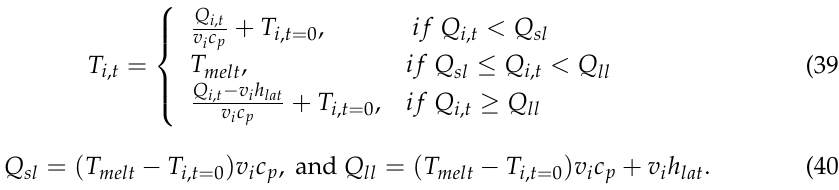
perform durably and effectively. Considering an average price of 124 EUR/m 3 in 2018 for dry concrete (National Ready Mixed Concrete Association—NRMCA—Industry Data Survey 2018), a rounded price of 200 EUR/m 3 dry concrete (ca. 60% above the mentioned average) was assumed in this work to account for the specificities of the thermal concrete. For each storage configuration, an appropriate storage container is selected. For the LHTS system steel plates are considered to encapsulate the PCM, whereas for the concrete storage system, the tube bundle arrangement does not require any containing vessel since the concrete surrounding the tubes will remain solid and contain itself. A simple metallic structure can hold the tube bundle together. The proposed structure is similar to the con- figuration proposed by EnergyNest for their pre-commercial concrete TES system [16]. For both LHTS and the concrete storage, thermal insulation is used around the con- tainer and the metal structure, respectively. Insulation costs are calculated using a corre-